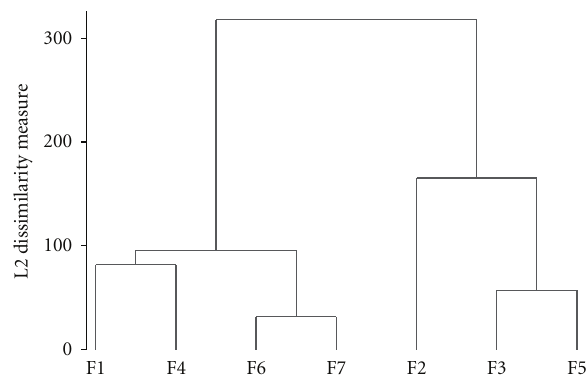
Figure 1: Hierarchical cluster analysis of the studied soils in relation to the physical-chemical variables